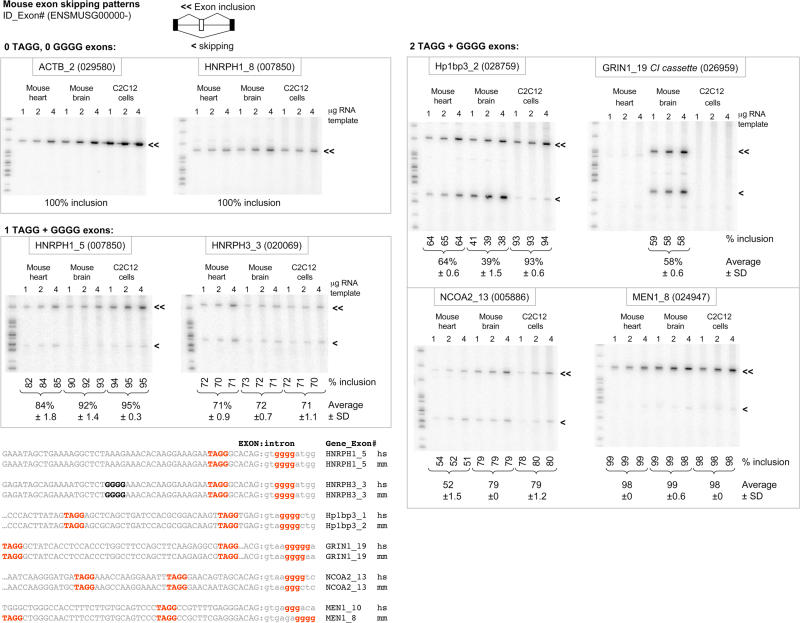
Analysis of Splicing Patterns in Mouse Tissues for Variations in the Number of Exonic UAGGsSplicing patterns were determined by radiolabeled RT-PCR for selected mouse exons. Control reactions include β-actin exon 2 and HNRPH1 exon 8, which were selected because they lack the silencing motifs studied (“0
TAGG, 0
GGGG exons”). HNRPH1 exon 5 and HNRPH3 exon 3 are representative of the one
TAGG plus
GGGG motif pattern (“1
TAGG +
GGGG exons”). Hp1bp3 exon 2, GRIN1 CI cassette exon, and NCOA2 exon 13 are examples of tissue-specific exon skipping associated with the two
TAGG plus
GGGG motif pattern (“2
TAGG +
GGGG exons”). MEN1 exon 8 is also shown. Each gel panel shows splicing patterns tested in RNA samples from mouse heart and brain tissue and mouse C2C12 cells. Gene name, exon number, and Ensembl gene ID (in parentheses) are provided above each gel panel. Curly brackets point to the average percent exon inclusion and standard deviation for each set of serial dilutions; raw values are given immediately below each lane. Sequence alignments (bottom left) of the corresponding human and mouse orthologs illustrate the patterns of silencer motifs (orange). Bold indicates an additional exonic
GGGG motif.